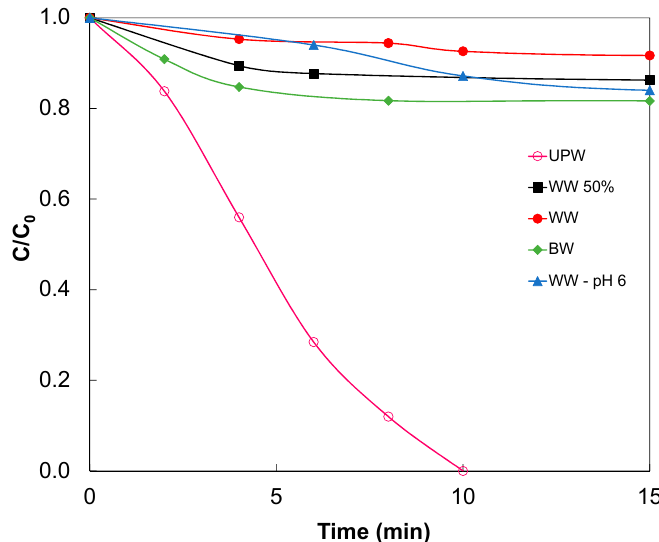
Figure 6. E ff ect of water matrix on SMX degradation. Experimental conditions: C SMX = 500 µ g / L; Figure 6. Effect of water matrix on SMX degradation. Experimental conditions: C SMX = 500 μ g/L; C LNO C LNO = 250 mg / L; C SPS = 100 mg / L; room = 250 mg/L; C SPS = 100 mg/L; room temperature.